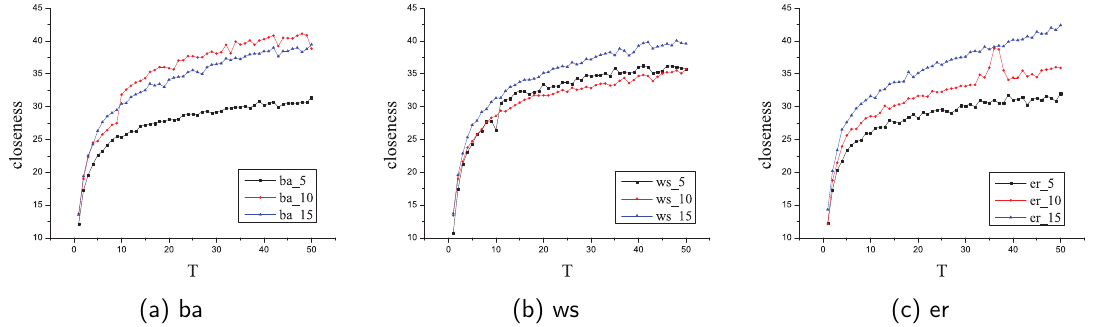
Figure 4. The average speed up ratio T in different sizes and kinds of random networks. Table 4. Complex network datasets used in evaluating the efficiency of our UpdateCloseness